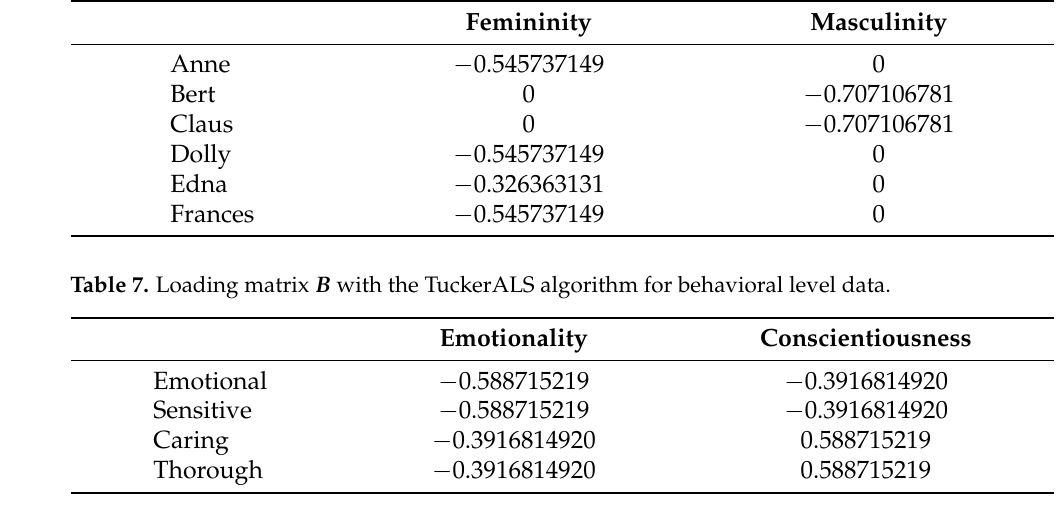
Table 8. Loading matrix B with the DisjointTuckerALS algorithm for behavioral level data.